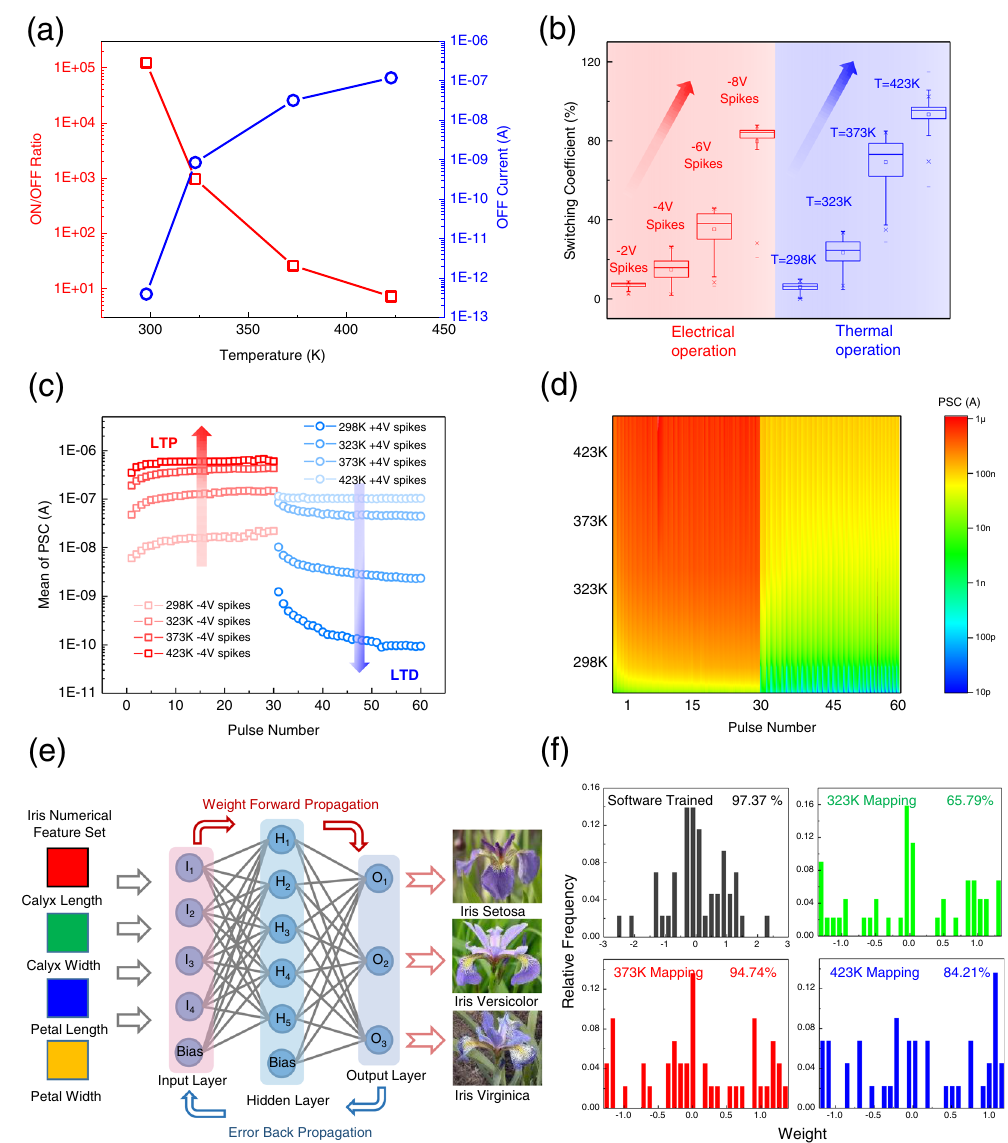
Fig. 5 Flexible thermal tunable memory switching and neuromorphic computing of 2D α -In 2 Se 3 FeCTs. a ON/OFF ratio and off-state current under thermal temperature modulation, which shows a progressively decreasing ON/OFF ratio (red square curve) and increasing off-state current (blue circular curve). b Electrically or thermally modulated switching coef fi cients, which raise with increasing spike amplitude (red region) or thermal temperature (blue region), indicates the depolarization of α -In 2 Se 3 channel ferroelectric and re fl ects the electrothermal tunability of FeCTs NVM. c The mean PSC varies with thermal temperature and spike numbers, which demonstrates the neuroplasticity of LTP and LTD. The increase in PSC is accompanied by an increase in thermal temperature, which corresponds to strengthened LTP, while the PSC in LTD decreases with declining temperature, which implies enhanced inhibition, as shown by the red and blue arrows, respectively. d Continuous PSC mapping with thermal temperature and spikes dependence, which successively performs excitatory and inhibitory stimuli. The interface of potentiation and inhibition is clear, and as temperature and spikes accumulate, excitatory PSC increase, while inhibitory PSC do the opposite. e The schematic of fully connected neural network based on α -In 2 Se 3 FeCTs for iris recognition and classi fi cation. f The weight distribution and accuracy of simulated fully connected neural network, including software-trained and thermally